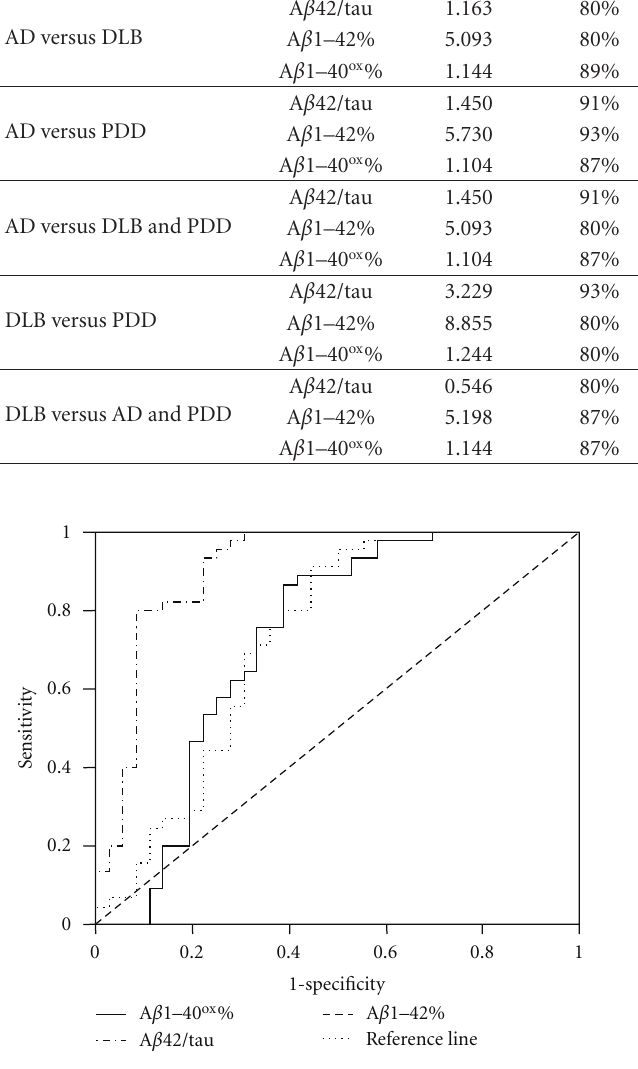
Figure 2: Receiver operator curves for detection of DLB among AD and PDD as a combined group using A β 42/tau, A β 1–42% and A β 1– 40 ox %,